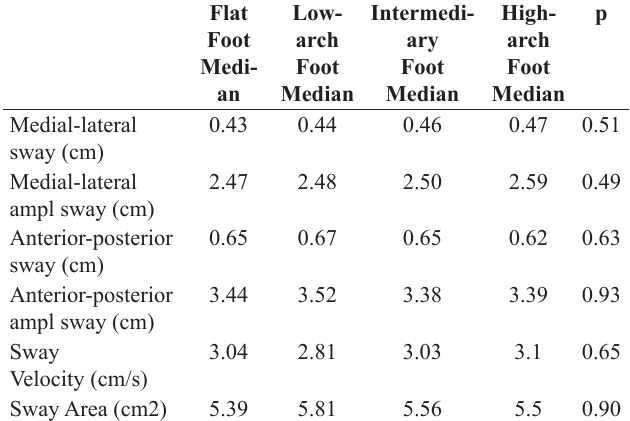
Table 3. Comparative table of the types of plantar arches and the bal- ance data.